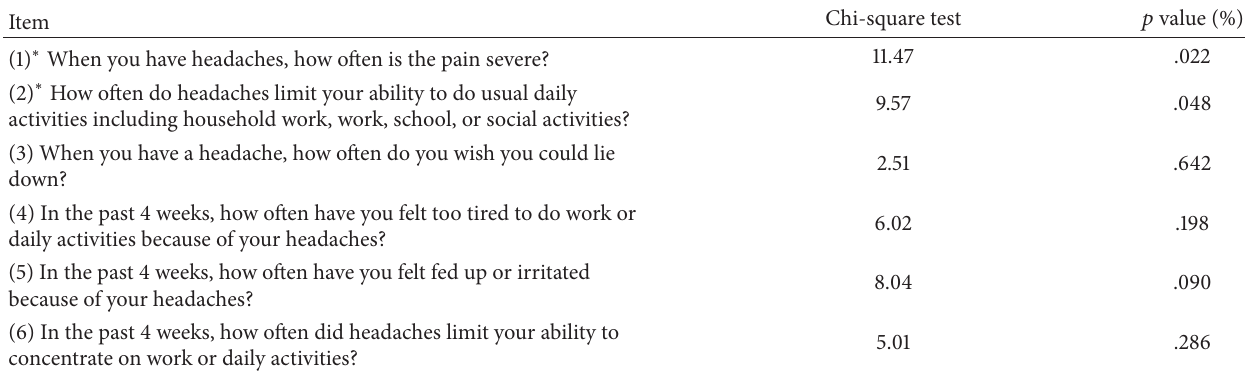
Table 4: Comparison of headache impact symptoms in migraine and no migraine groups on the HIT-6.